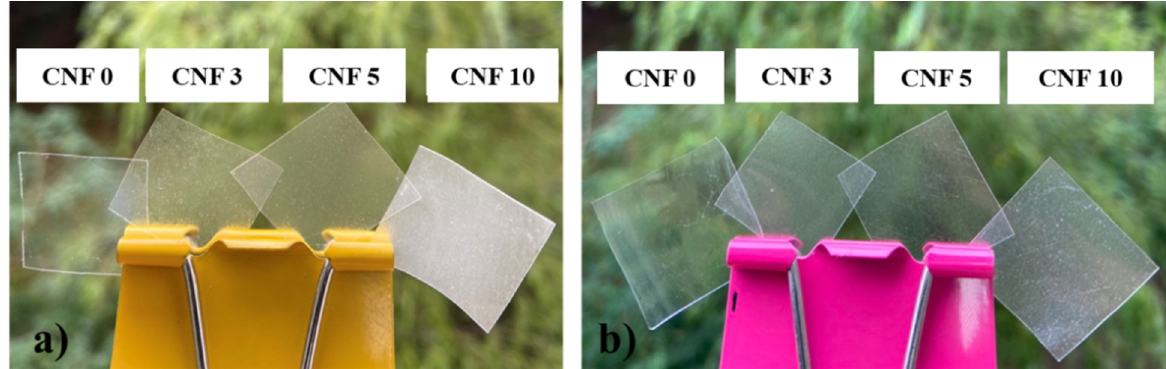
Figure 2. Tensile strength ( a ), elastic modulus ( b ), and elongation at break ( c ) of CA/TC/CNF and CA/TA/CNF in acetone and NMP solvent (Plasticizer content 30%).